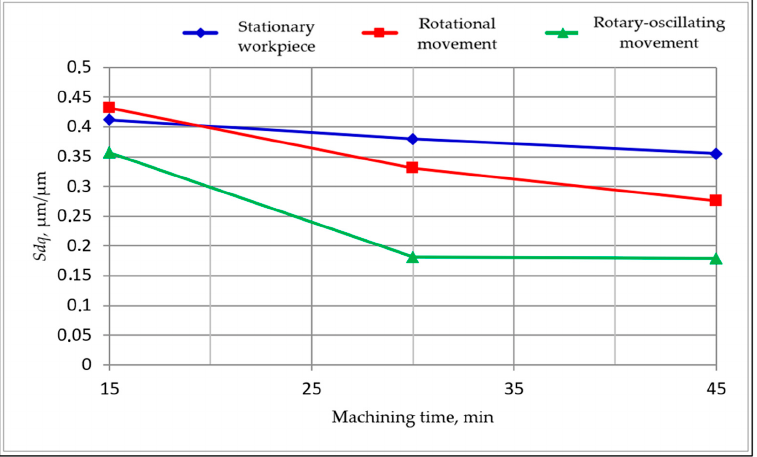
Figure 7. Changes of the root mean square gradient Sdq as a function of machining time.